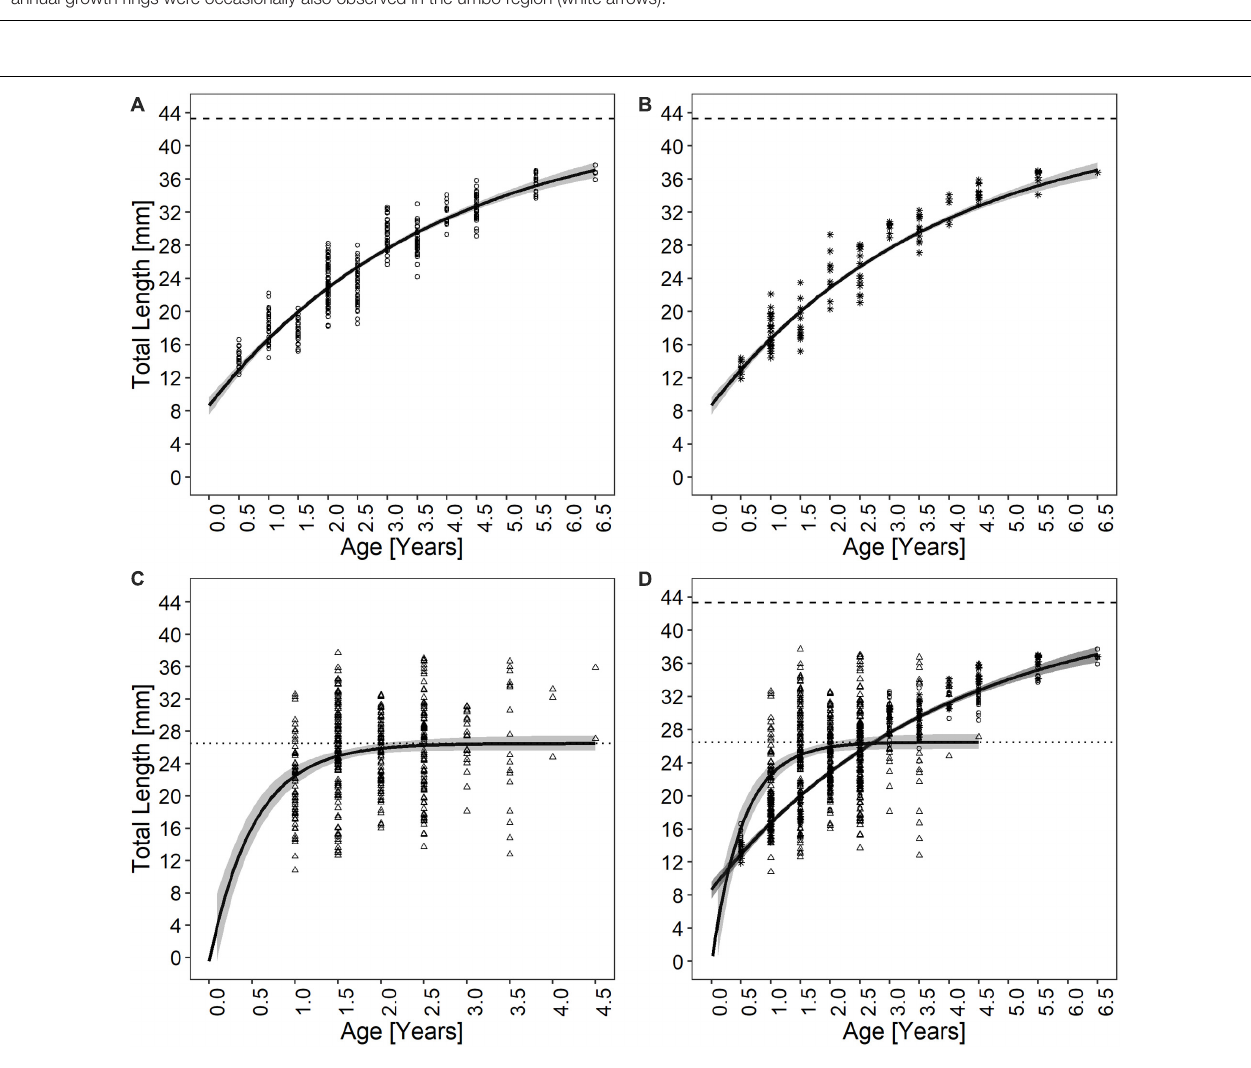
FIGURE 3 | Chamelea gallina growth curves determined using (A) thin sections, (B) acetate peel replicas, (C) surface growth rings, and (D) by fitting all the von Bertalanffy (VBF) growth curves together. The shaded areas around the growth curves are the 95% CIs. Different dot types represent the observed individuals, being respectively 353 for both thin sections and surface growth rings techniques and 118 for the acetate peels.